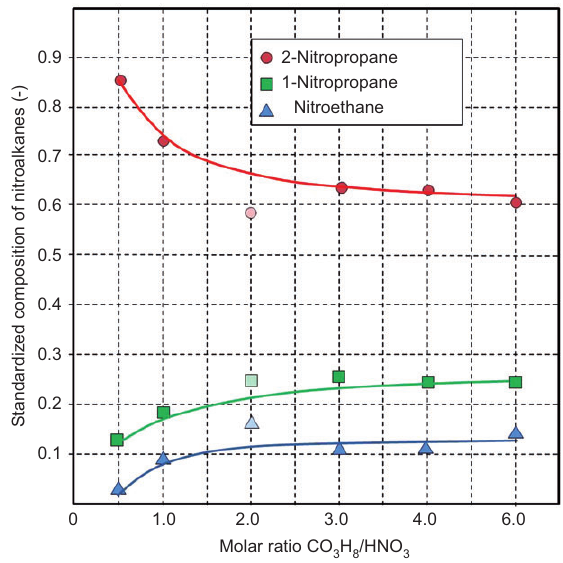
Figure 9 Nitroalkanes ratio dependent on the molar ratio of C HNO . 2-Nitropropane is the preferred product at low 3